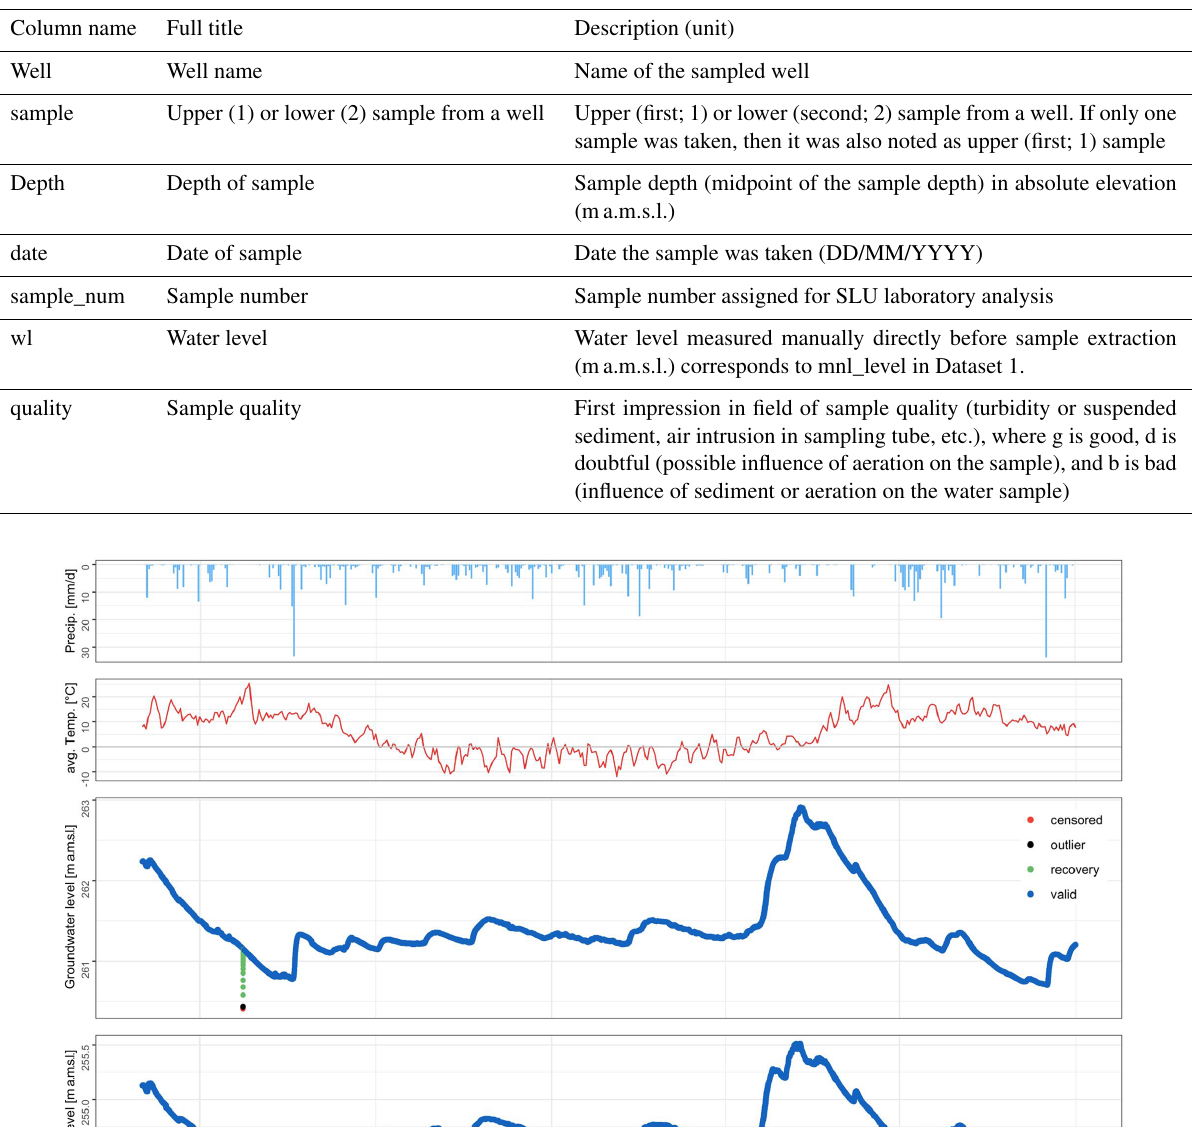
Table 2. Description of groundwater sampling data (file 2022-020_Erdbruegger-et-al_Krycklan_sampling.csv).